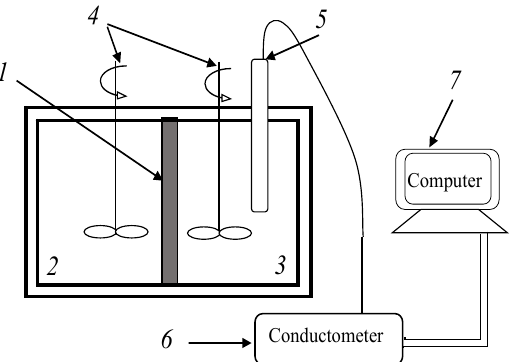
Figure 1. Scheme of a cell for measuring the diffusion permeability of a membrane: 1 —Anion-exchange membrane under study, 2 —chamber with amine salt solution, 3 —chamber with deionized water, 4 —mixers, 5 —conductometric sensor, 6 —conductometer, 7 —computer.